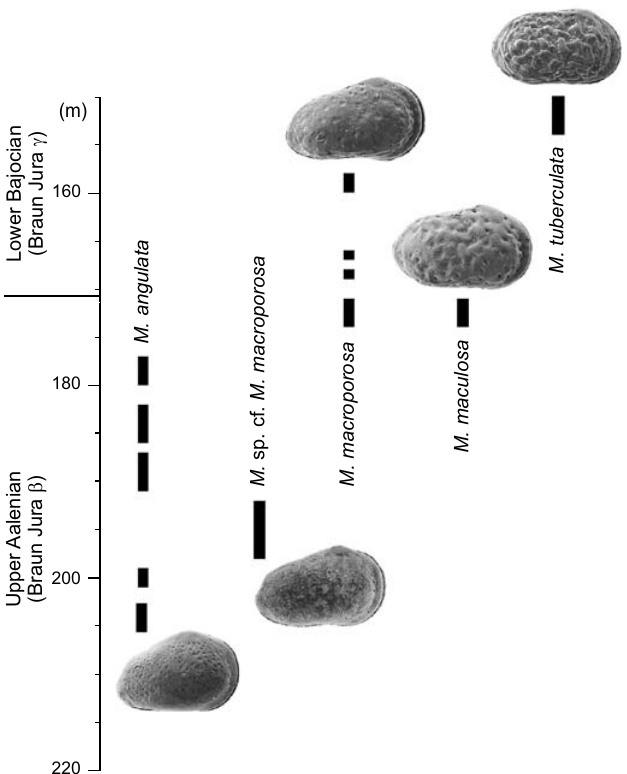
Fig. 21. Stratigraphic distribution of Minyocythere angulata sp. nov., Minyocythere sp. cf. M . macroporosa sp. nov., Minyocythere macroporosa sp. nov., Minyocythere maculosa (Bate, 1963), and Minyocythere tubercu- lata (Luppold, 2012) in Borehole Hambühren WA2, NW